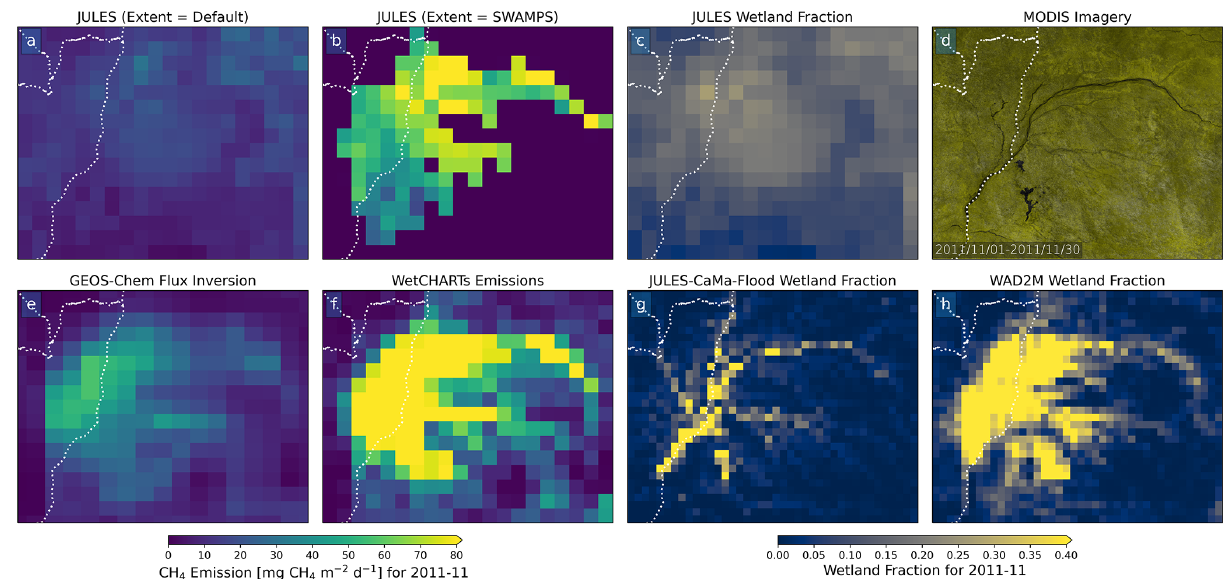
Figure 12. Comparison over the Congo wetland region showing the wetland CH 4 emissions for November 2011 for (a) JULES with the default wetland extent, (b) JULES with the SWAMPS masking for wetland extent, (e) GEOS-Chem flux inversion of GOSAT XCH 4 over Africa and (f) the WetCHARTs ensemble mean. Also shown are the wetland fractions from (c) JULES, (g) JULES-CaMa-Flood and (h) WAD2M along with (d) MODIS (RGB) surface reflectance. Both JULES simulations are the configurations that use the WFDEI meteo- rological driving, the higher Q 10 value and phenological vegetation, as these were shown to provide the best result over this region (see Fig.